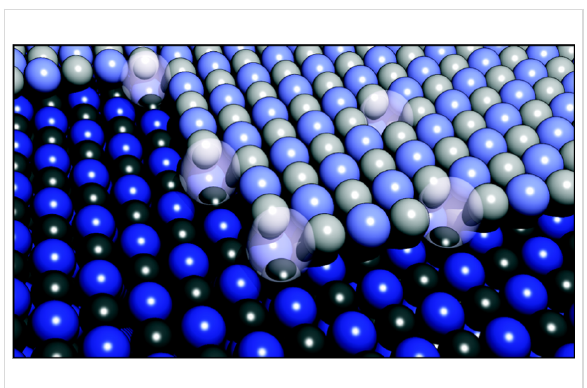
Figure 1: Model of a binary oxide surface. Point defects such as color centers, which are preferably situated at lower coordinated sites, are sketched as bright